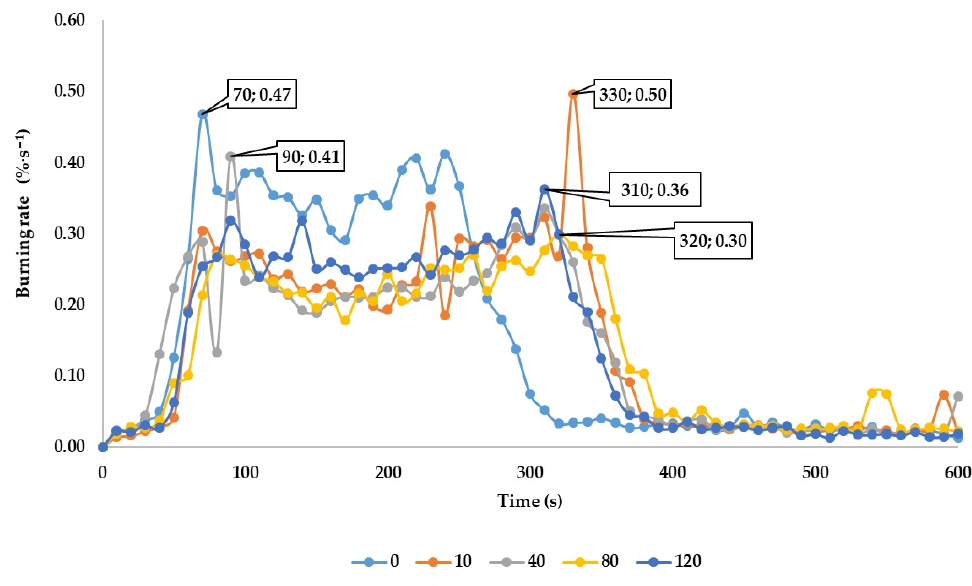
Figure 1. The absolute burning rate of the oak